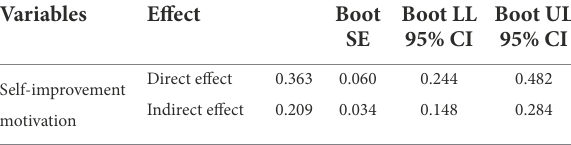
TABLE 3 Coworkers’ perceived status threat as mediator in the relationship between leaders’ voice endorsement and coworkers’ self-improvement motivation.